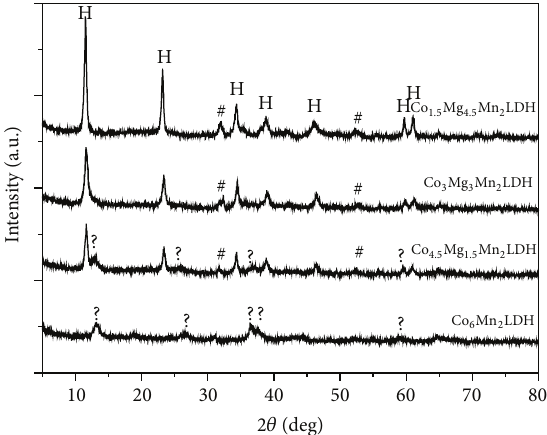
Figure 1: XRD patterns of the Co 𝑥 Mg 6−𝑥 Mn 2 LDH precursors (H: hydrotalcite-like compounds; #: MnCO 3 ; ?: unidentified